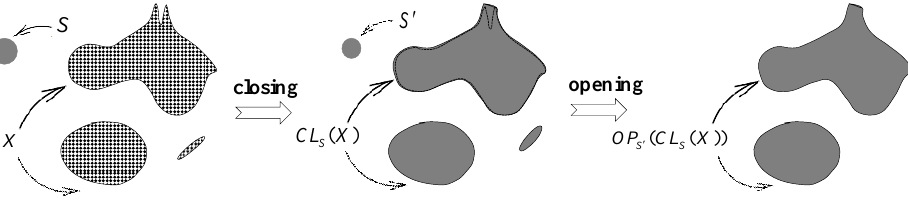
Figure 4. Schematic diagram of the preprocessing of discrete data by using morphological opera- tion.